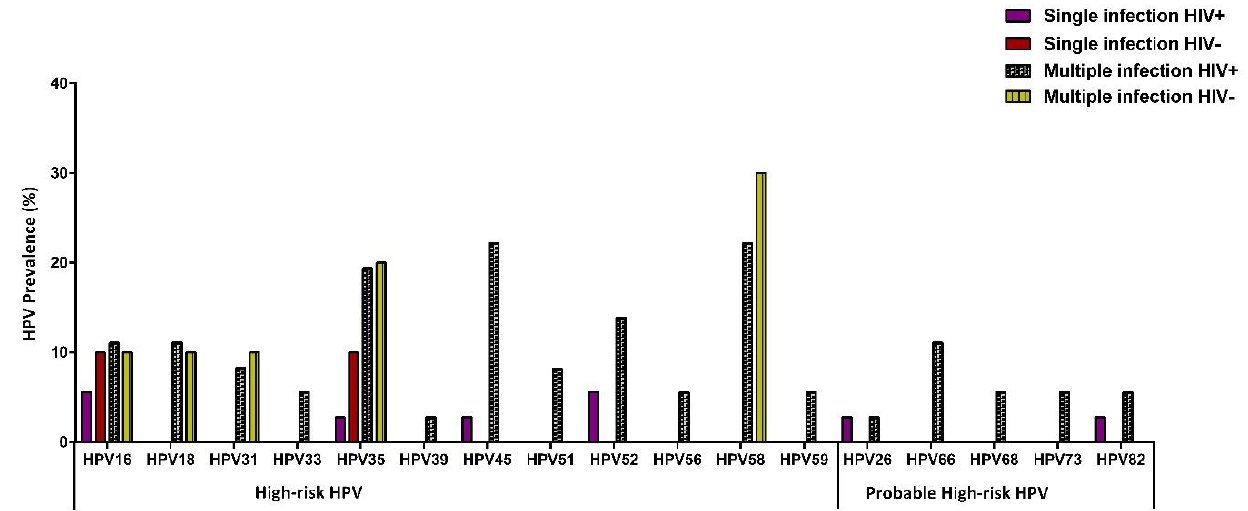
Figure 3. Distribution of HPV types among women with CIN2 in single and multiple infections according to HIV status.